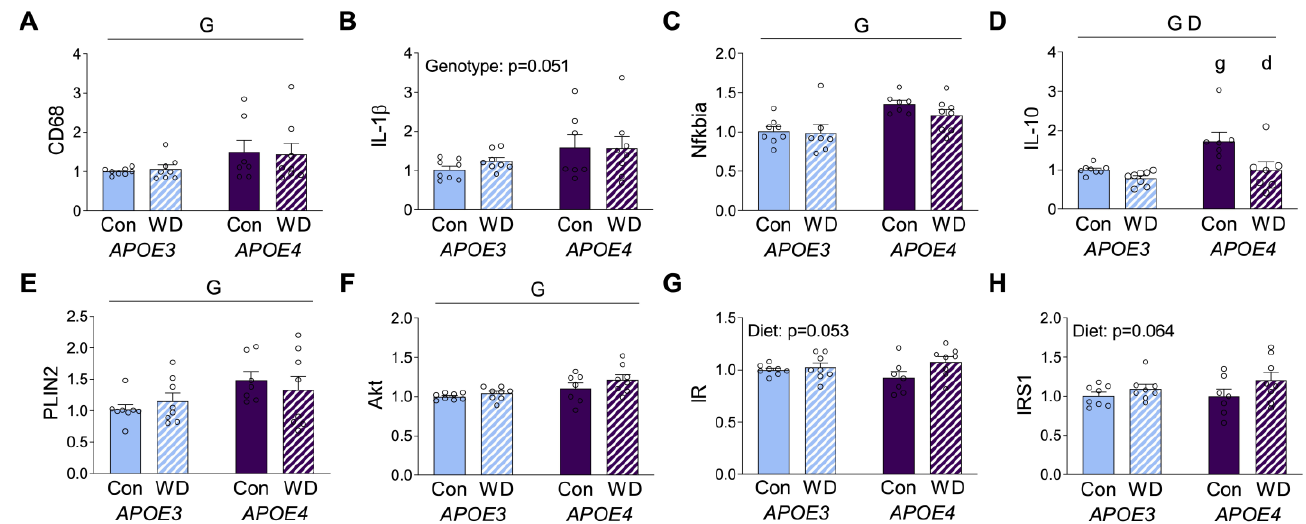
Figure 4. RNA expression levels in cerebrocortical brain tissue. Results of mRNA quantification studies in APOE3 (blue) and APOE4 (purple) mice maintained on control (Con; solid bars) or Western (WD; hatched bars) diets. Gene targets included the macrophage marker, ( A ) CD68, the inflammatory markers ( B ) IL-1 β , ( C ) Nfkbia, and ( D ) IL-10, and the metabolic markers ( E ) PLIN2, ( F ) Akt, ( G ) IR, and ( H ) IRS1. Data show fold difference as individual values (open circles) and mean values (+SEM) relative to the Con APOE3 group from n = 7–8 mice per group. “G” indicates a significant main effect of APOE genotype, “D” indicates a significant main effect of diet, “g” indicates a significant difference from APOE3 mice on the same diet, and “d” indicates a significant difference from animals with the same APOE genotype on the control diet. Significance is p < 0.05.